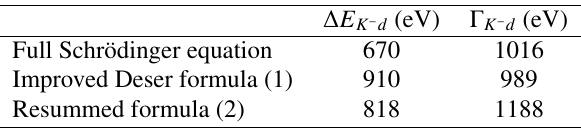
Table 2. Level shift and width of kaonic deuterium obtained by solving the three-body Schrödinger equation with the Kyoto ¯ KN potential, and by using the improved Deser formula (1) and its resummed version (2). The numerical data are taken from Ref. [19].